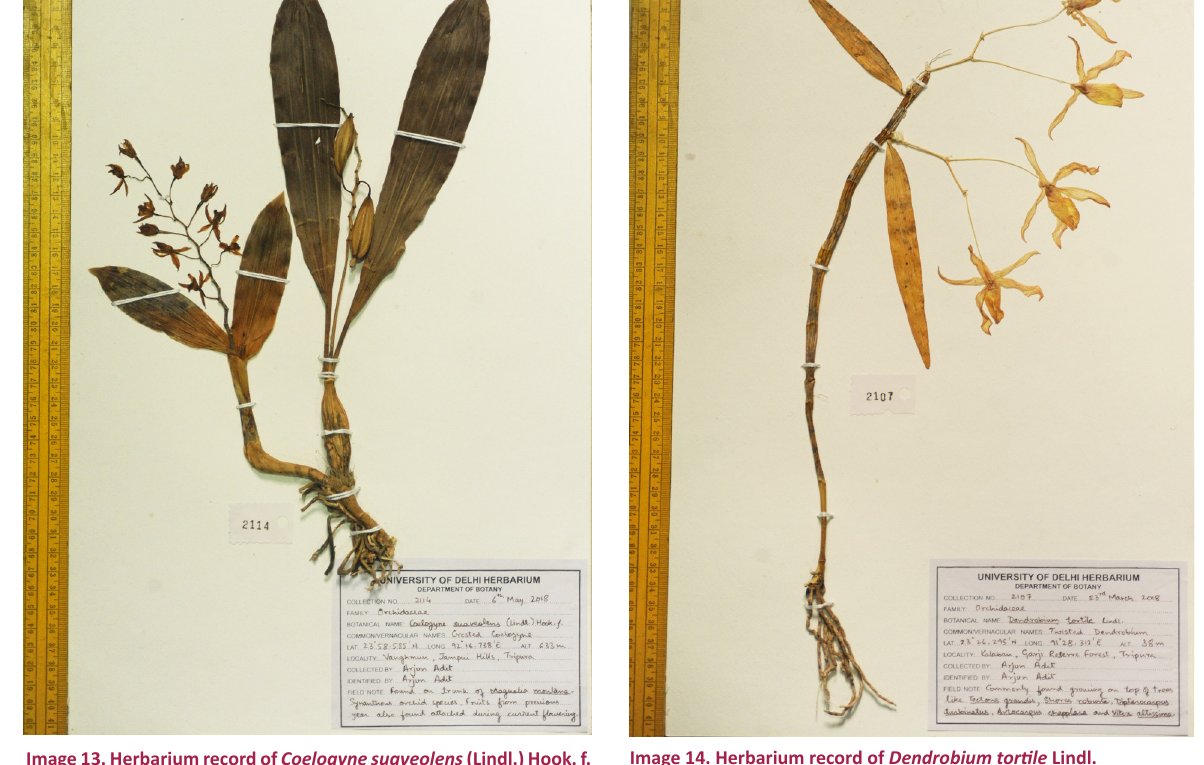
Image 13. Herbarium record of Coelogyne suaveolens (Lindl.) Hook. f. Image 14. Herbarium record of Dendrobium tortile